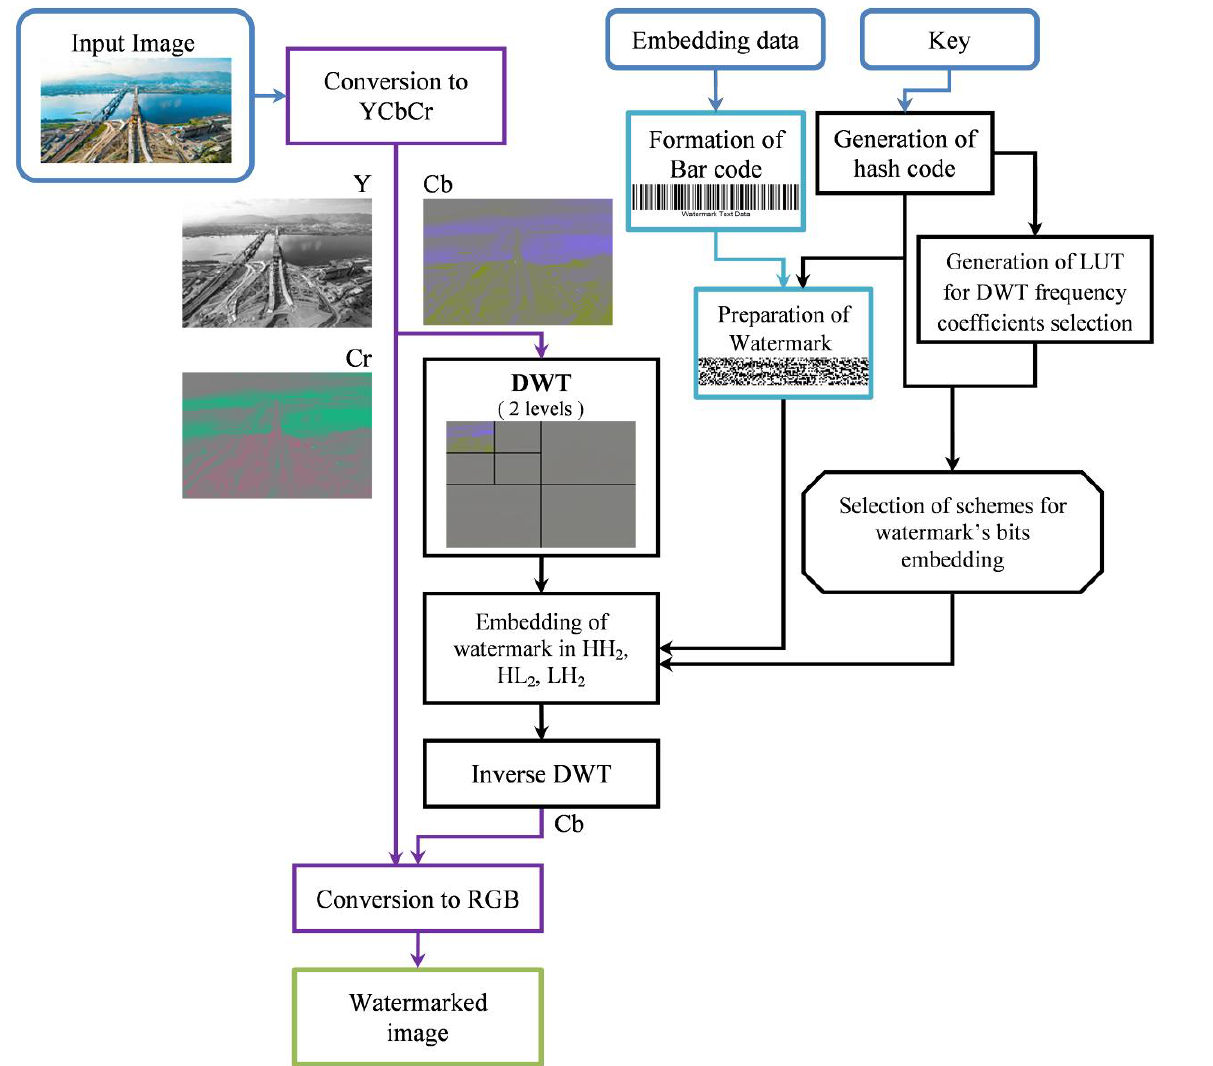
Figure 1 . Flow-chart of the proposed watermark embedding